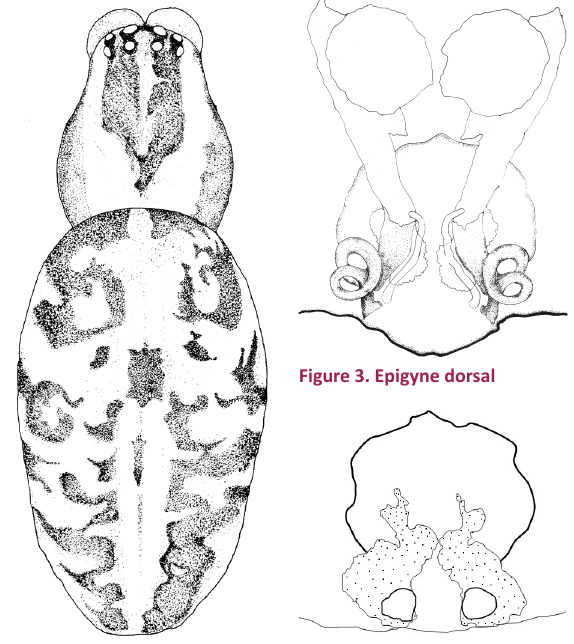
Figure 2. Habitus, dorsal Figure 4. Epigyne